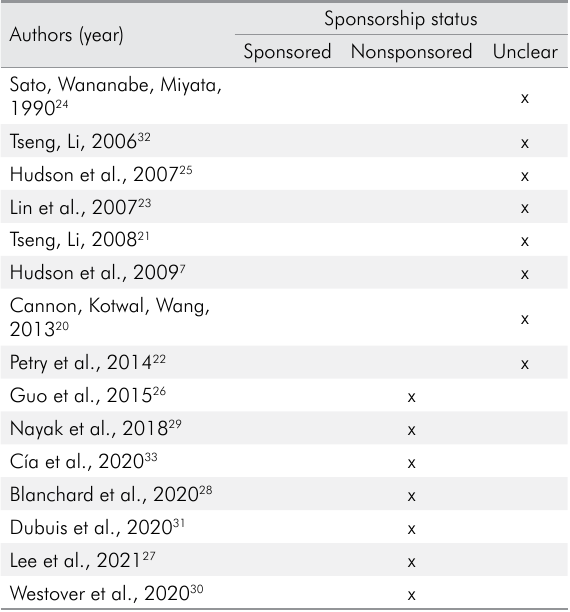
Table 4. Sponsorship status of the